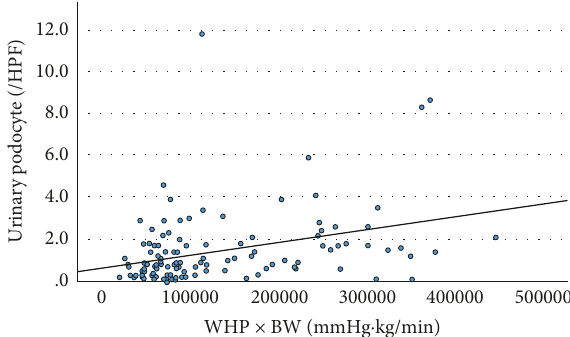
Figure 5: Correlation between water hammer pressure × BW and